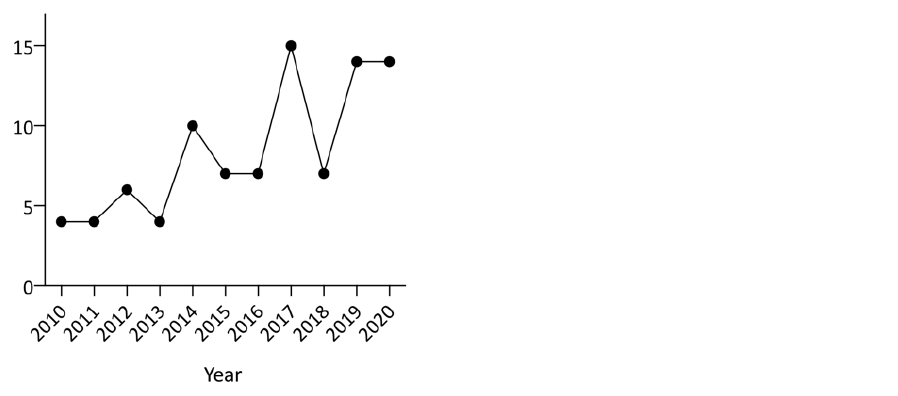
Figure 3. The number of oncolytic virus clinical trials commenced each year since 2010 and registered at ClinicalTrials.gov.